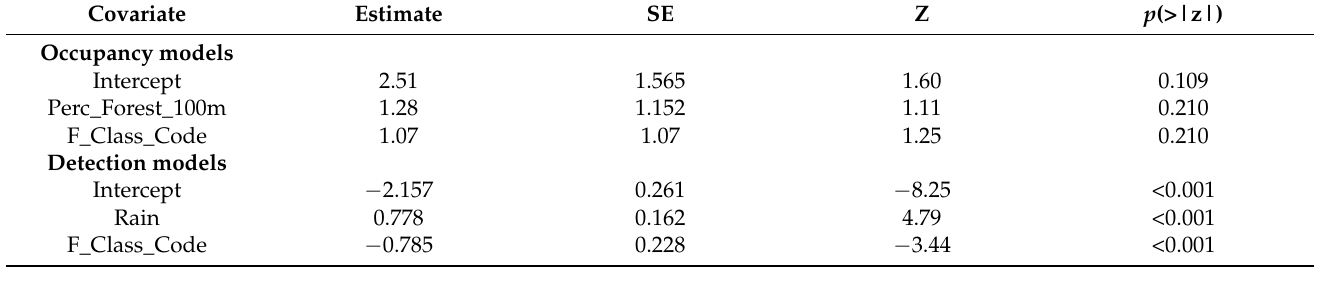
Table 3. Results of the most supported models for occupancy and detection at the 100-m scale for Rhode Island, USA, 2019–2021. Intercept is the mean value for occupancy, and detection,